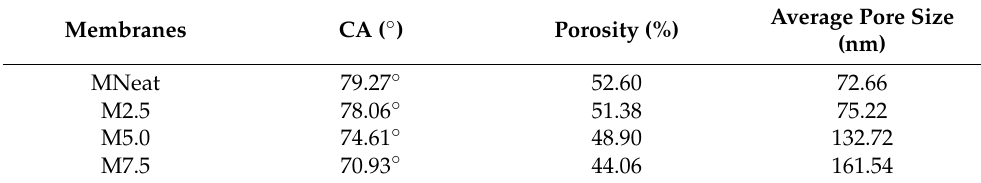
Table 3. CA ( o ) value, average pore size and porosity of MNeat and all AHFM. Membranes